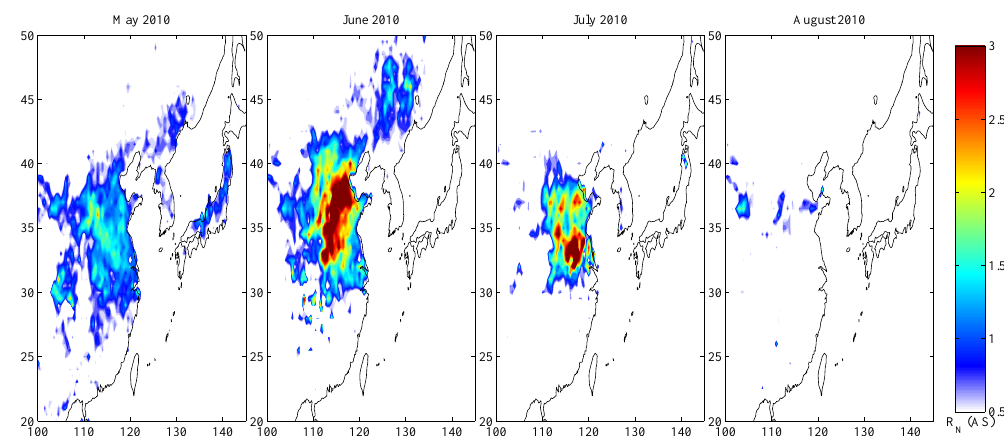
Fig. 10. Ammonium sulfate detected over East China for four consecutive months May–August 2010 (land only).